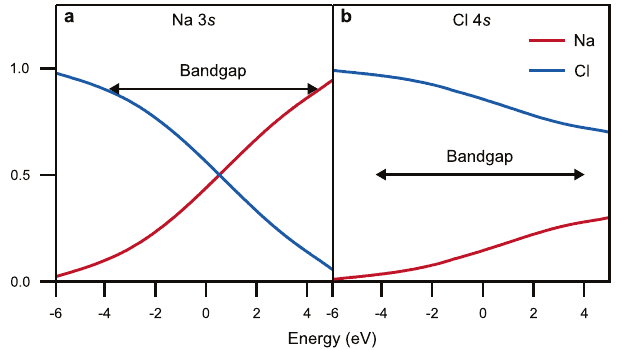
Fig. 3 Character of the gap states of NaCl including Madelung potential. Normalised relative weight of gap states on Na and Cl atoms in the outermost NaCl layer as a function of energy, E , in or close to the gap (indicated by the arrows). The parameters were adjusted so that the conduction states have mainly a Na character and b Cl character. The Figure illustrates that electrons travelling through the gap at energies close to the conduction band, have similar character as those in the conduction